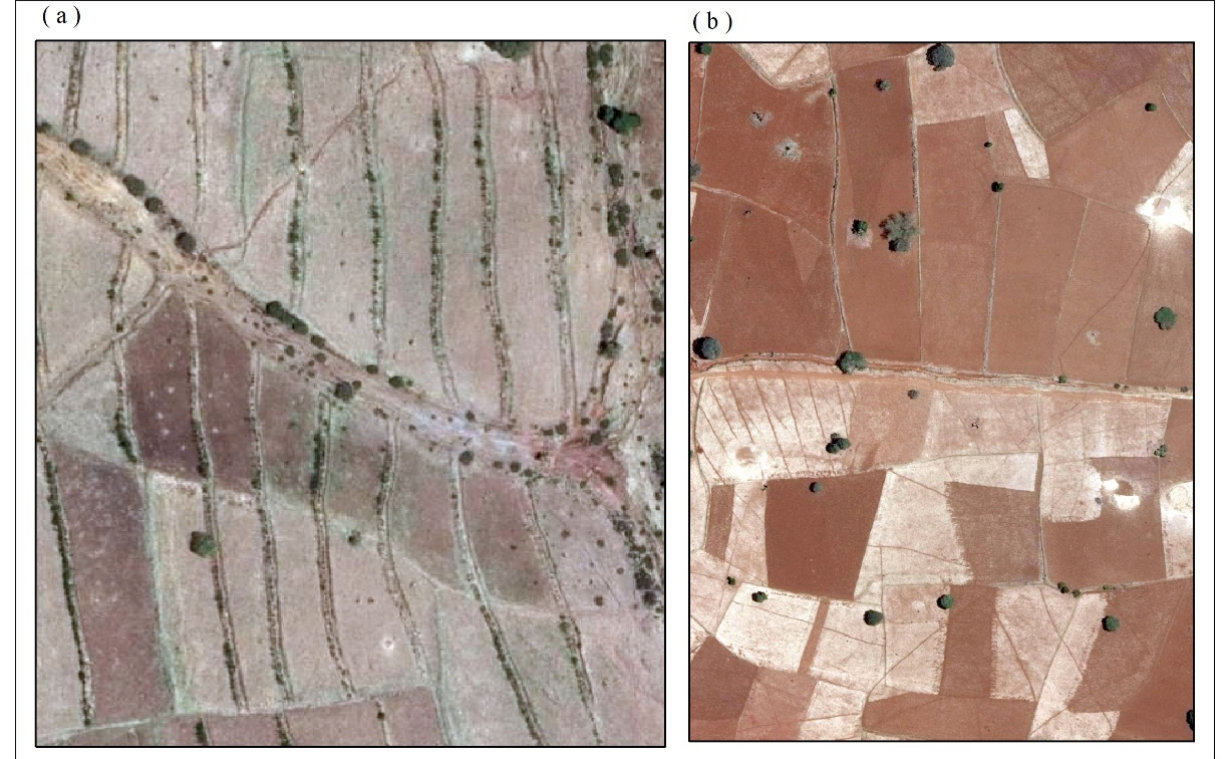
Figure 2. Farmlands in the study area: ( a ) treated with stone and soil bunds in Debre Mewi, and ( b ) untreated with SWC structures in Sholit sub-watershed (photo taken: May 2020).